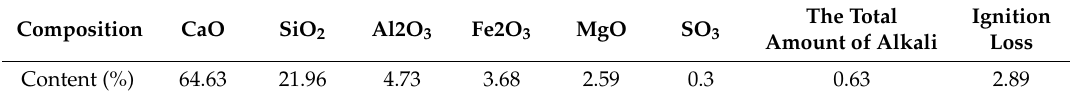
Table 2. Chemical composition of cement.